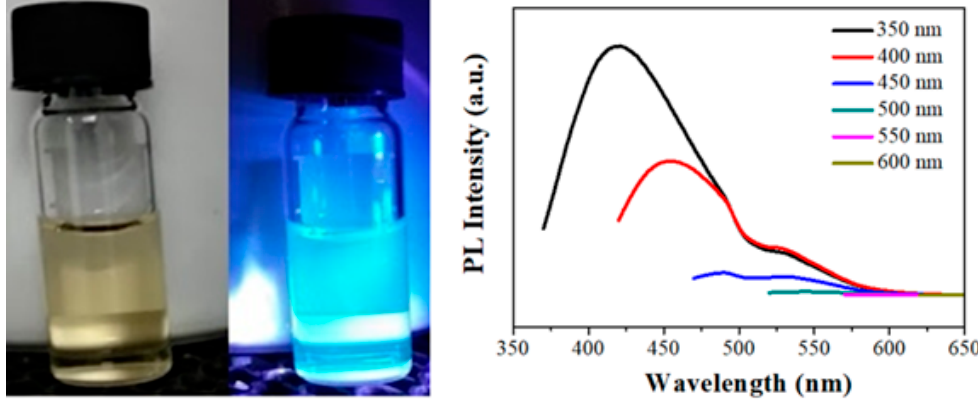
Figure 13. Left : aqueous dispersion of carbon dots under natural and UV light. Right : fluorescence emission spectra of the dots at different excitation wavelengths ( λ ex as inset).